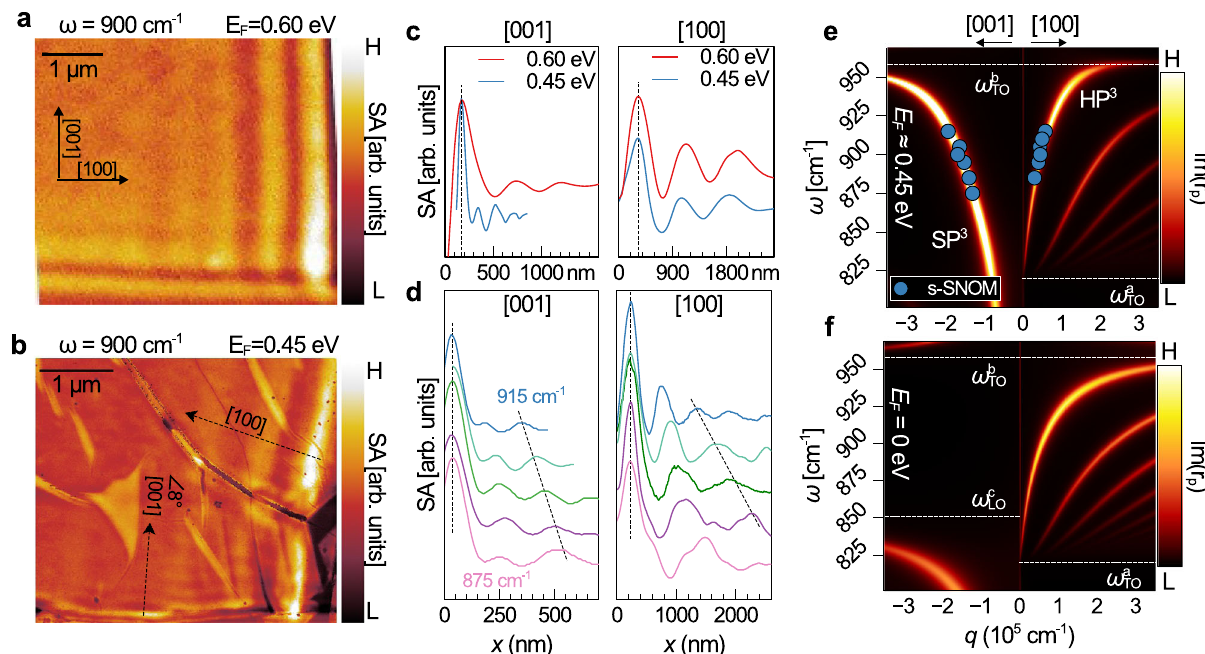
Fig. 3 Tuning hybrid modes by WO x /WSe 2 layer number and laser frequency. Near- fi eld amplitude images of, a WOx/graphene/ α -MoO 3 with ~0.60 eV hole doping and, b WO x /1L-WSe 2 /graphene/ α -MoO 3 with ~0.45 eV hole doping. [100] and [001] modes are visibly less anisotropic in the more highly doped sample. c Near- fi eld line pro fi les showing that increasing doping level substantially increases the wavelength of [001] modes, but only marginally increases [100] mode wavelengths. Black dashed lines align the fi rst peaks. d Line pro fi les extracted from the sample in b excited at different laser frequencies from 875 – 915 cm − 1 . Note [001] modes in b are re fl ected from a physical boundary of the WO x /graphene layer at 8° from the [001], which is practically equivalent to the [001] direction (Supplementary Fig. 6). e Momenta from fi tting pro fi les in d are consistent with the dispersion calculated from the imaginary part of the p -polarized re fl ection coef fi cient. ω j are TO(LO) frequencies of j -axis phonons: values plotted as white dashed lines. Note that TO ð LO Þ there is a splitting at ω b from the upper Reststrahlen band phonon not considered in Eq. 1. f Calculated dispersion of phonon polaritons in bare α -MoO 3 TO showing the absence of [001] modes for ω = 875 – 915 cm − 1